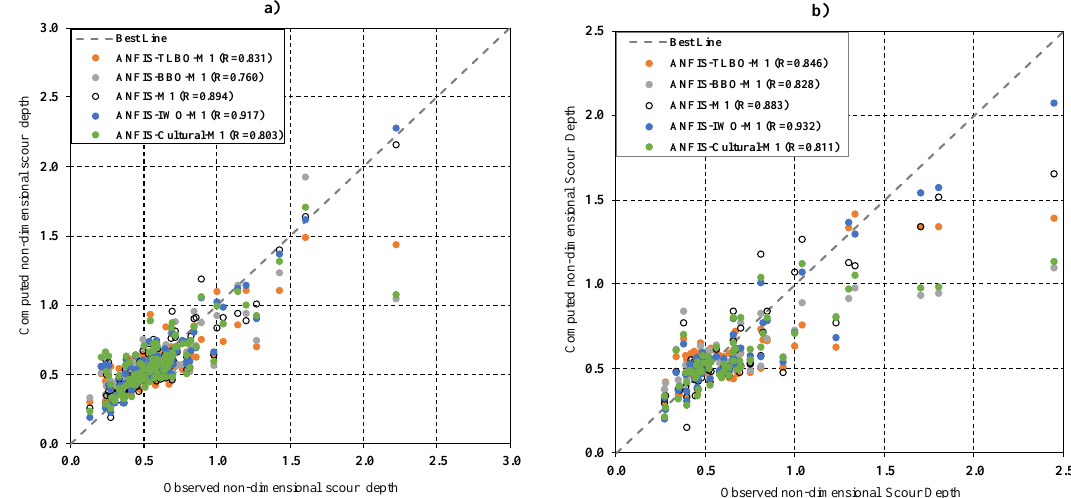
Figure 3. Scatter plots of the predicted values of scour depths against the observed ones: ( a ) training phase, ( b ) testing phase.